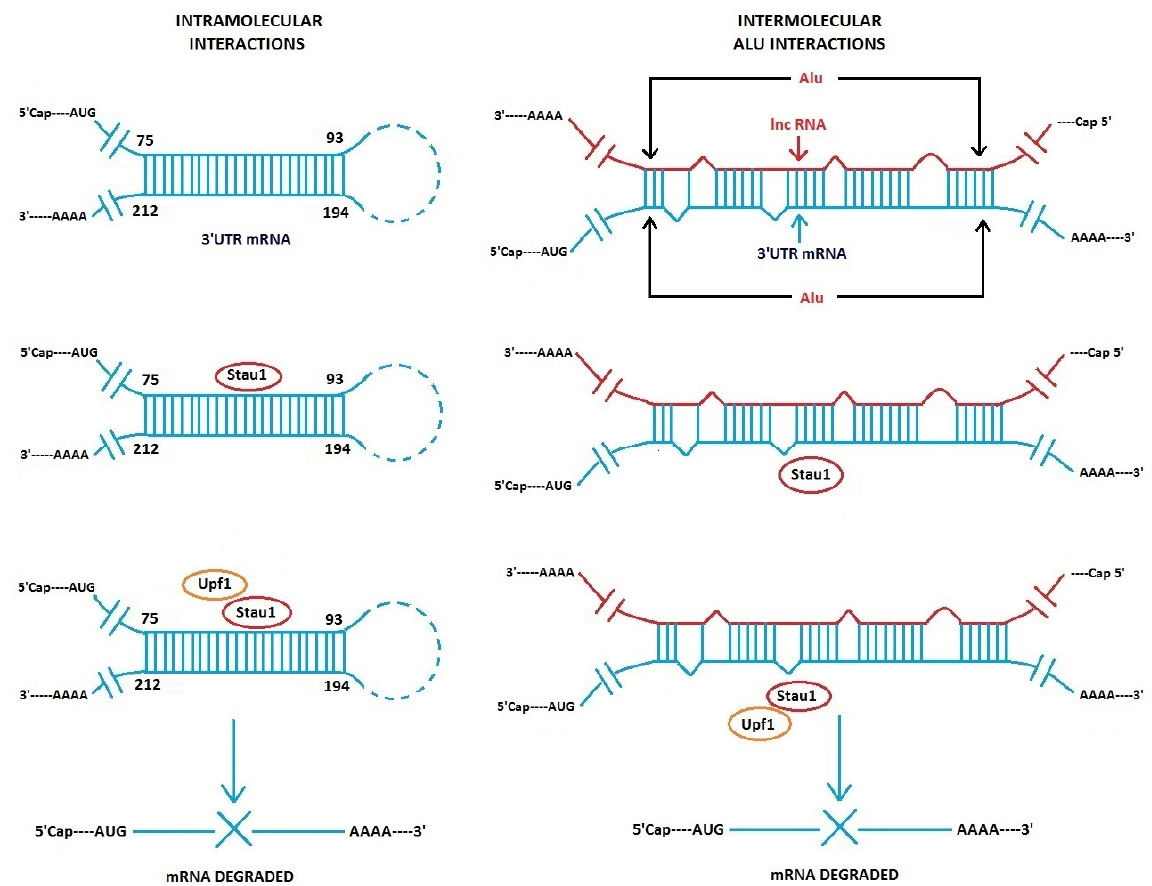
Figure 3. Schematic of binding of Stau1 to 3' UTR mRNA intramolecular stem ( arf1 mRNA) ( left ) and to intermolecular stem formed by Alu sequence in lncRNA with Alu sequence within 3'UTR mRNA. Upf1is an RNA helicase. The two RNA duplex stems shown are not drawn to scale. Modified from Gong and Maquat